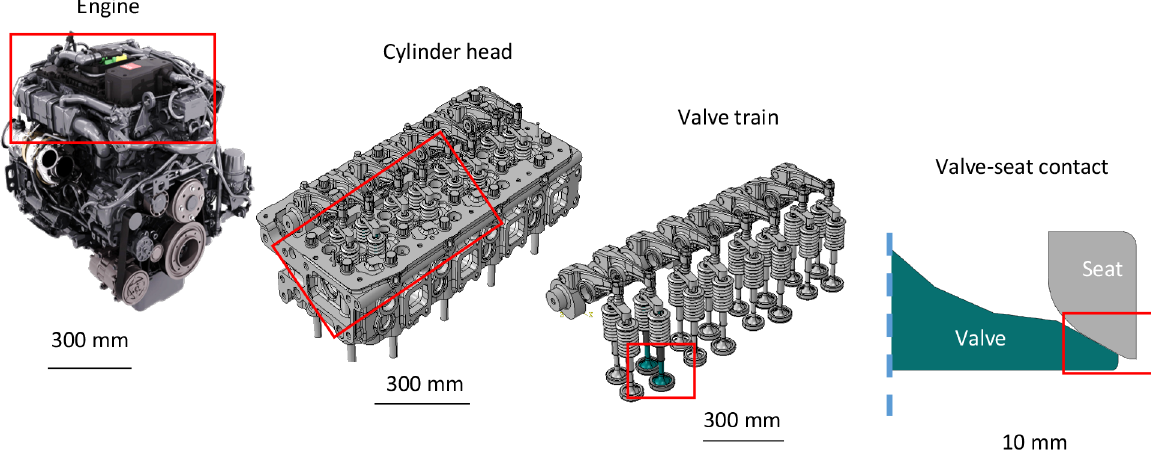
Fig. 1. Location of the valve-seat contact in between the engine (Turbocharged in-line engine, 4 cylinders, 5 litres, 16 valves).